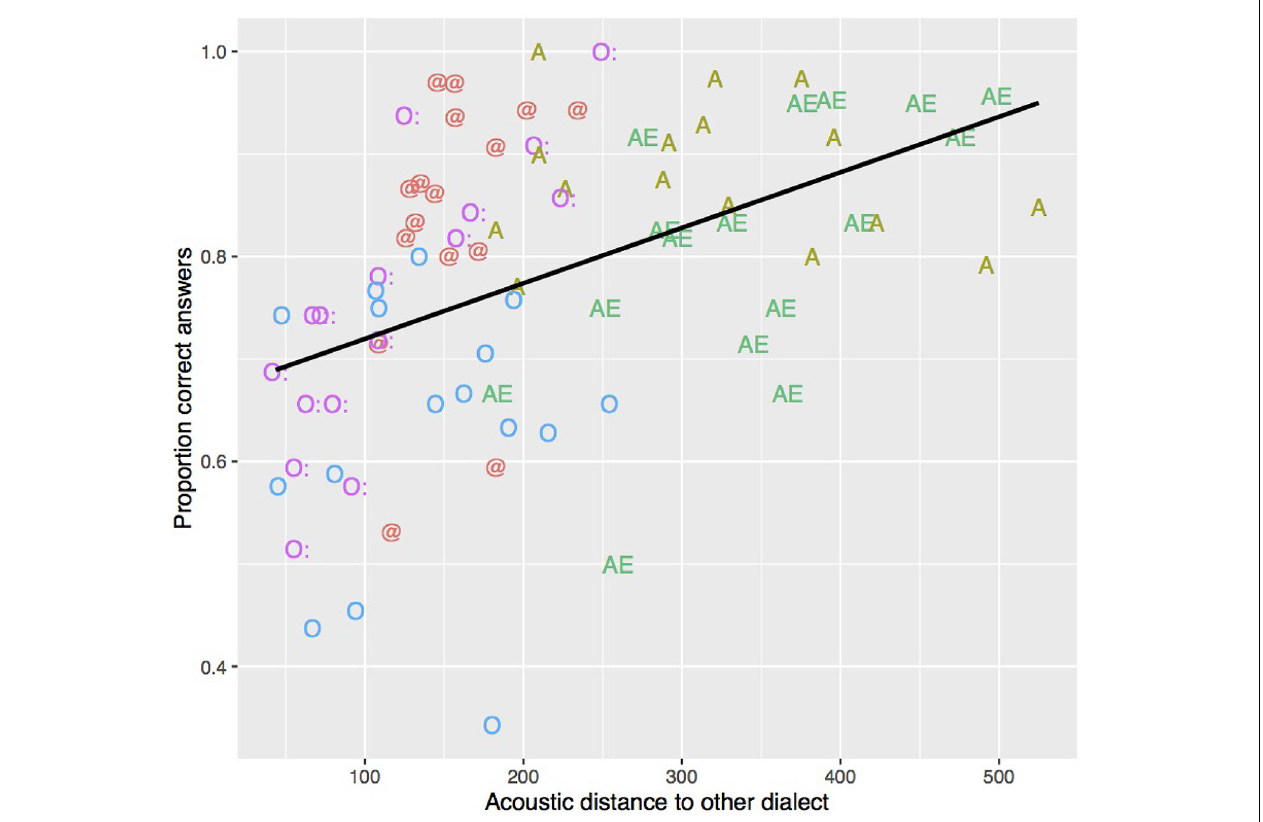
FIGURE 7 | Relationship between the proportion of correct answers (y-axis) and the acoustic distance to the other dialect (x-axis). The proportion of correct answers was calculated separately for each speaker and each dialect feature (i.e., each vowel), resulting in 5 (vowels) × 16 (speakers) = 80 data points. The acoustic distance was measured in mel as Euclidean distance between the target vowel in each stimulus and the centroid for the corresponding vowel in the other dialect. Each value on the x-axis thus represents the averaged Euclidean distance over a vocalic dialect feature and a speaker. For instance, for O, the average distance was calculated for each speaker over the words Loch , Frosch , and Schloss